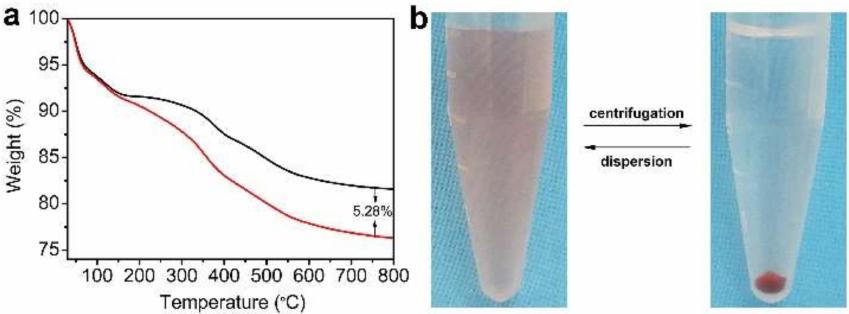
Figure 5. ( a ) TGA curves of MSNs-SH (black) and MSNs-SS-DMSA (red); ( b ) the dispersity of DOX − labeled MSNs-SS-DMSA in PBS buffer solution (pH